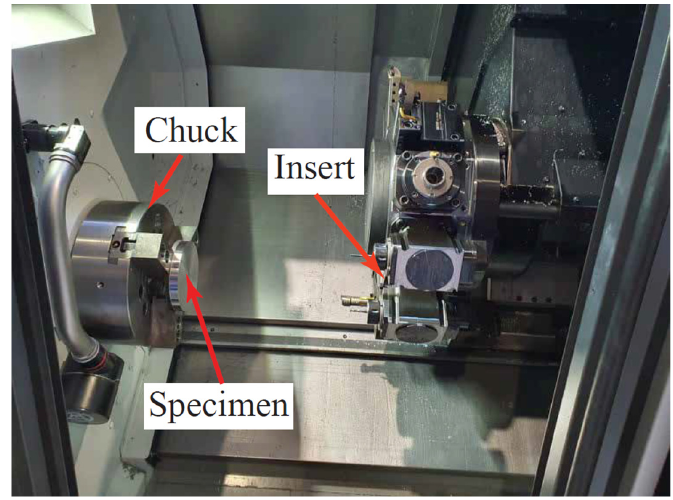
Figure 4. CNC lathe with the AISI 1045 specimen.